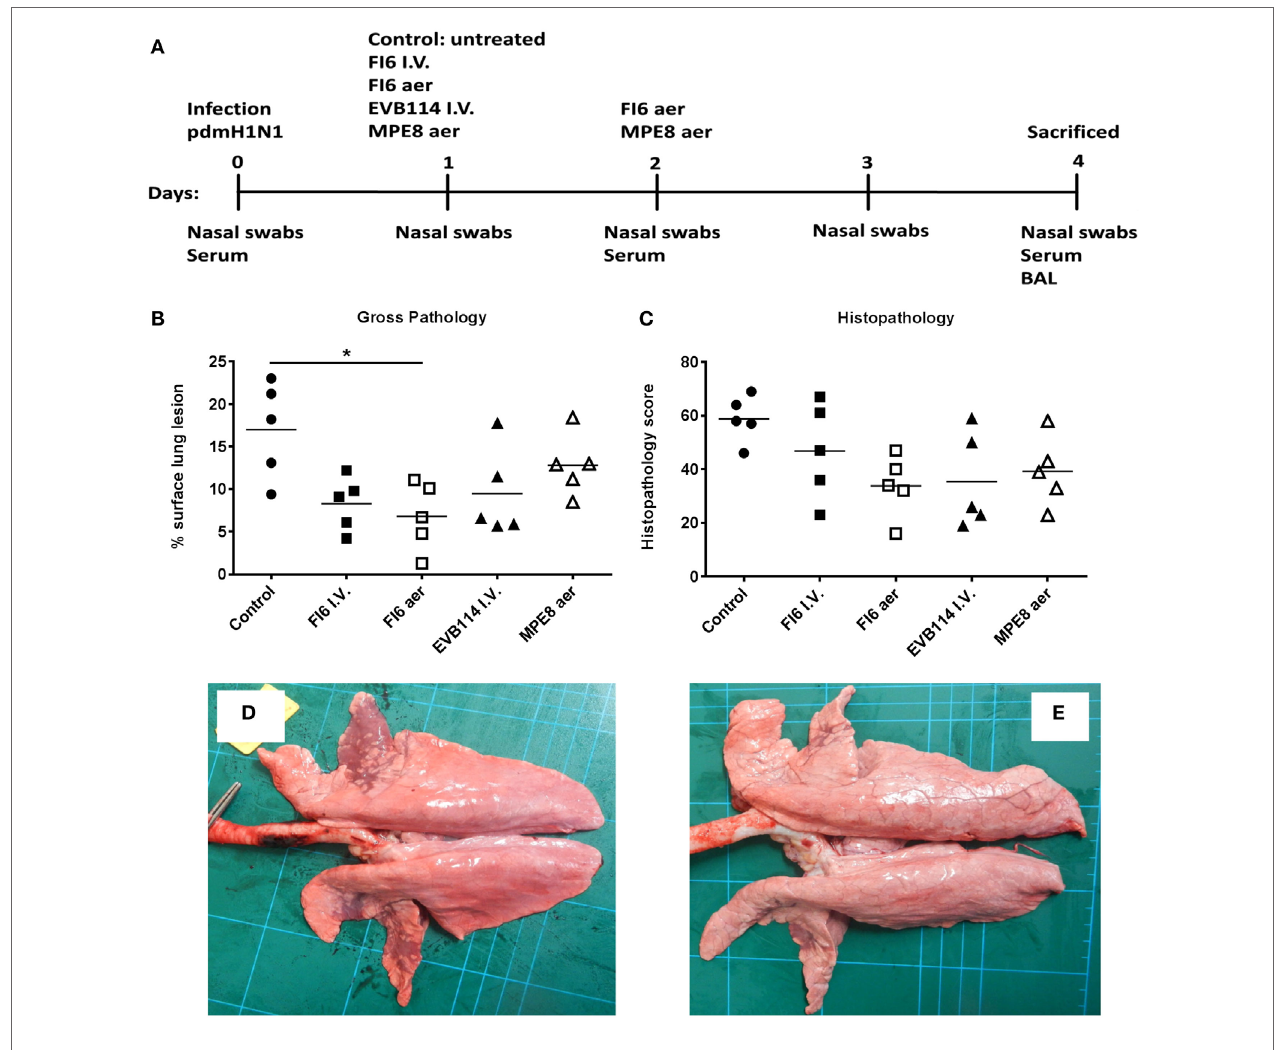
FigUre 1 | Experimental design and lung pathology. Pigs were infected with A/sw/Eng/1353/09 and received the indicated antibodies either by the intravenous route at 1 day post infection (dpi) or by aerosol at 1 and 2 dpi (a) . The animals were sacrificed at 4 dpi and lungs scored for appearance of gross (B) and histopathologcial lesions (c) . Each data point represents an individual within the indicated group and lines represent the mean. * denotes significant difference from the control group ( P < 0.05). Representative gross pathology of a pig from control group (D) and FI6 aerosol (e)